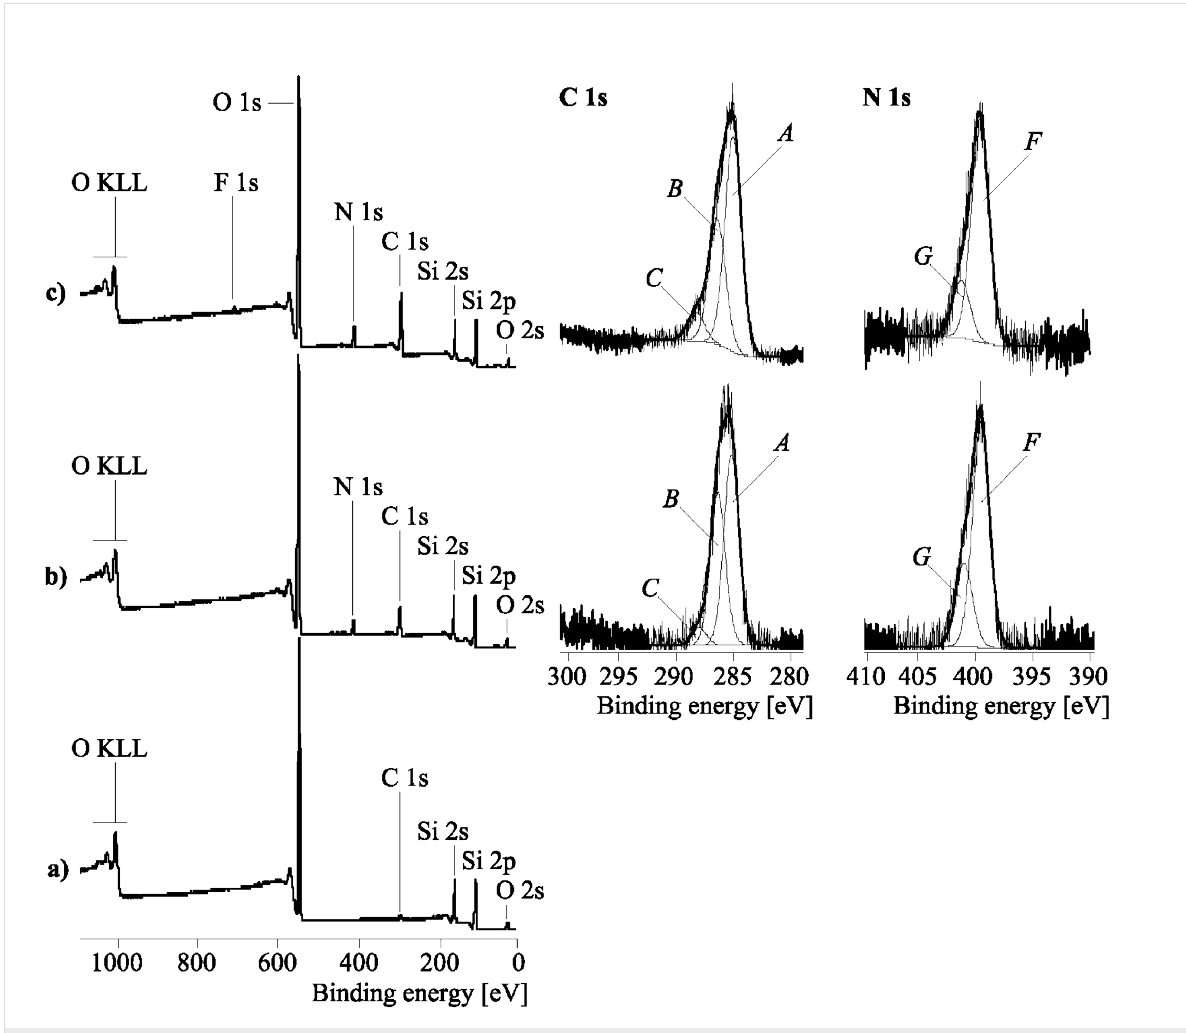
Figure 2: Wide-scan X-ray photoelectron spectra (left), C 1s and N 1s high-resolution spectra (right) of bare silica particles (a), PVAm adsorbed onto silica particles (b) and PVAm reacted with 1 on the surface of silica particles (c).